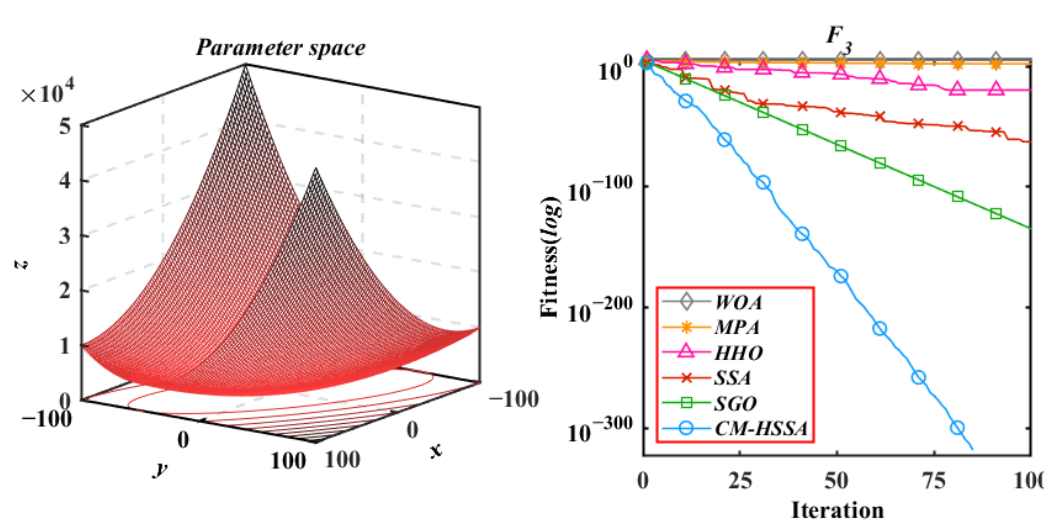
Figure 11. Schwefel ’s problem 2.22.